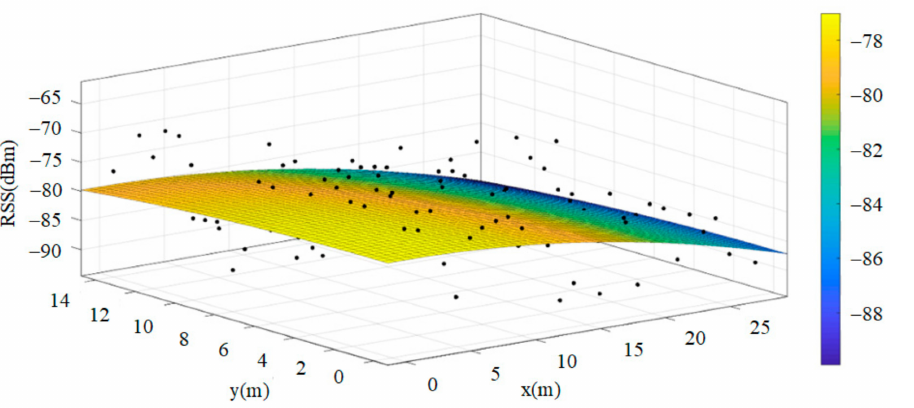
Figure 12. Fitting Model Generated for Base Station